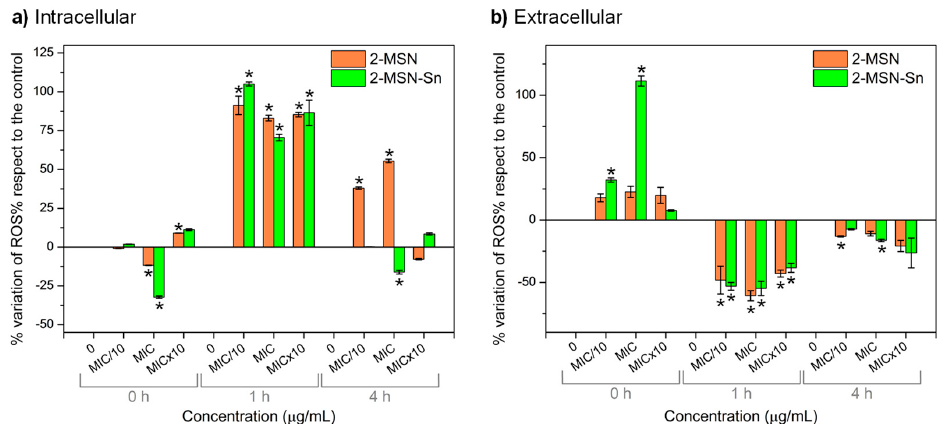
Figure 4. Percentage of variation of ( a ) intracellular and ( b ) extracellular ROS induced by 2-MSN and 2-MSN-Sn materials in S. aureus at 0, 1 and 4 h of incubation and at three material concentrations. The study was performed in triplicate and the data are expressed as mean ± SD. * p -value < 0.05 respect to control.